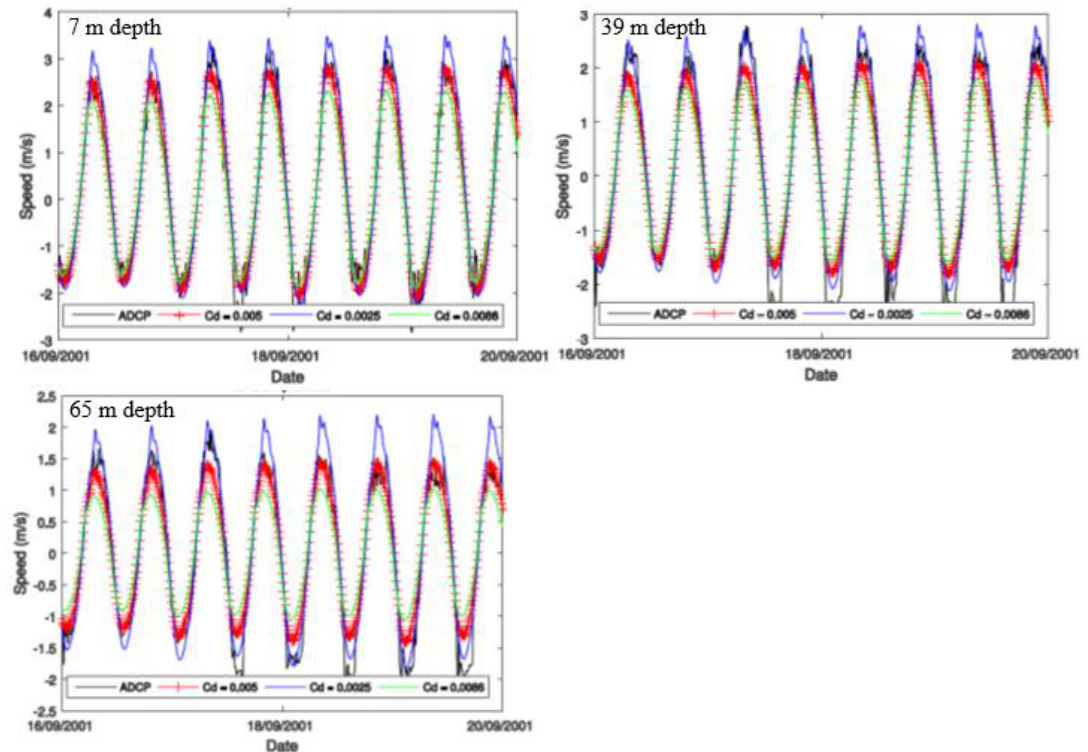
Figure 14. Tidal current prediction versus ADCP measurements for different depths measurements and for different seabed friction coefficients Cd [40].